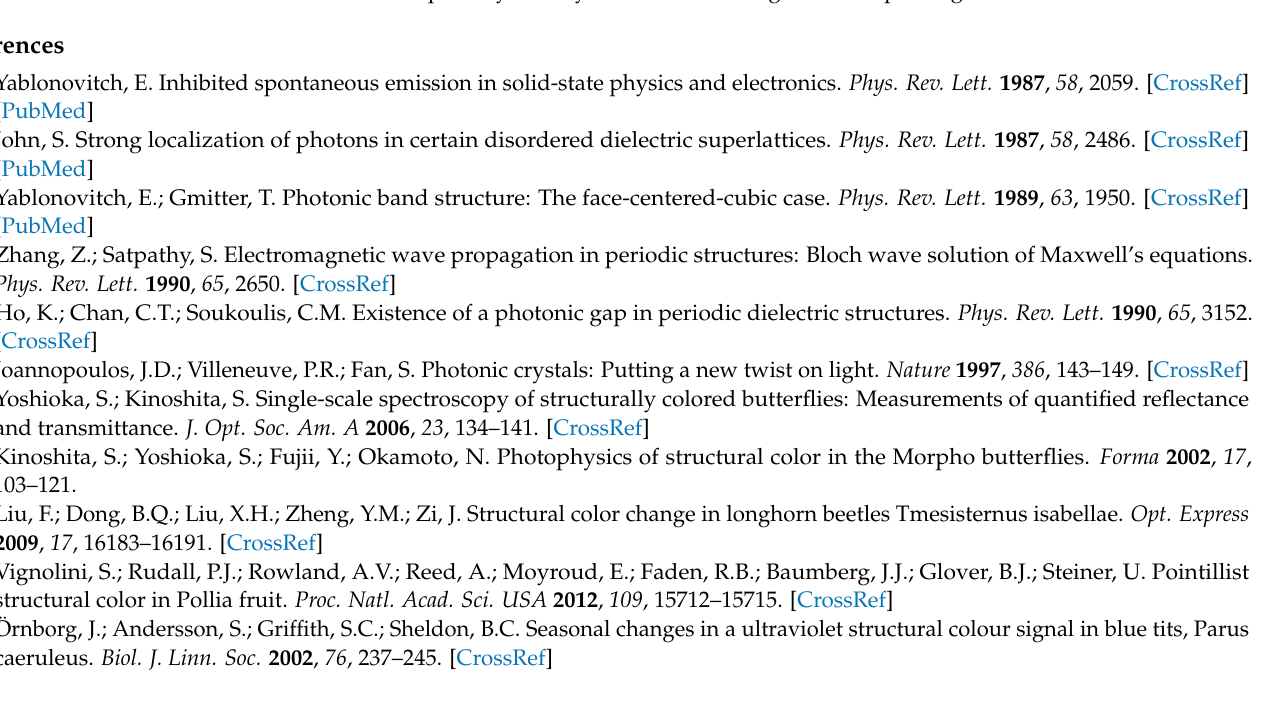
Figure A2. Fast Fourier transform (FFT) analysis (inset) of the SEM, as shown in Figure 1c of the 5 BIOS film. Examination of the corresponding radial distribution in the ( left ) panel shows a single predominant nonzero spatial frequency, with a peak intensity at approximately 6 µ m − 1 , corresponding to a real-space periodicity of approximately 165 nm in good agreement with the DLS characterization of the particle size (and, thus, the 111-plane packing distance). The nature of this packing was additionally elucidated in terms of a 2D spatial autocorrelation function ( right ), showing a distinctive six-point symmetry indicative of hexagonal close packing.